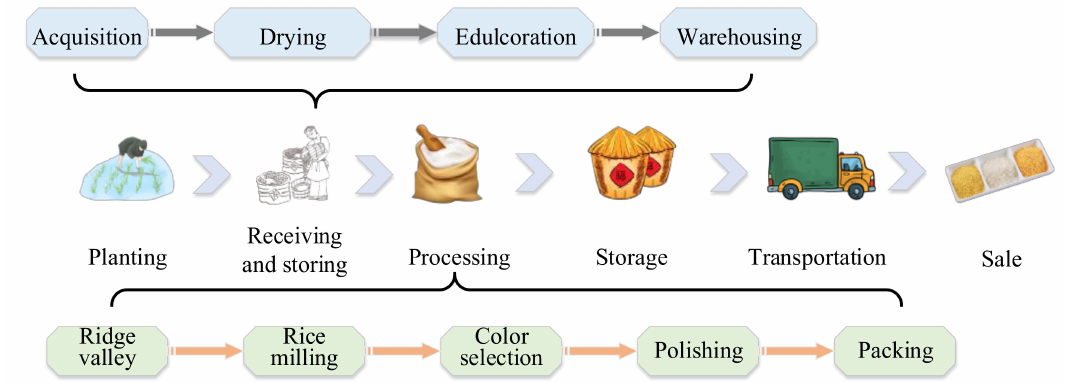
Figure 1. Schematic diagram of the classification of rice supply chain